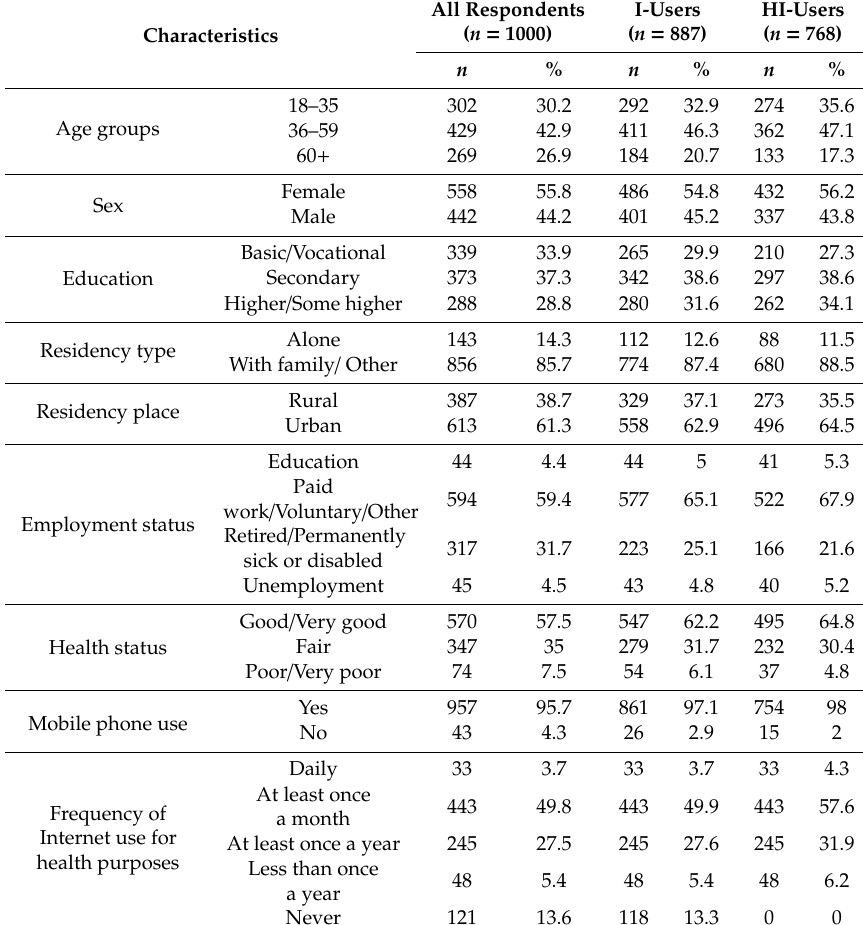
Table 1. Characteristics of the study group.